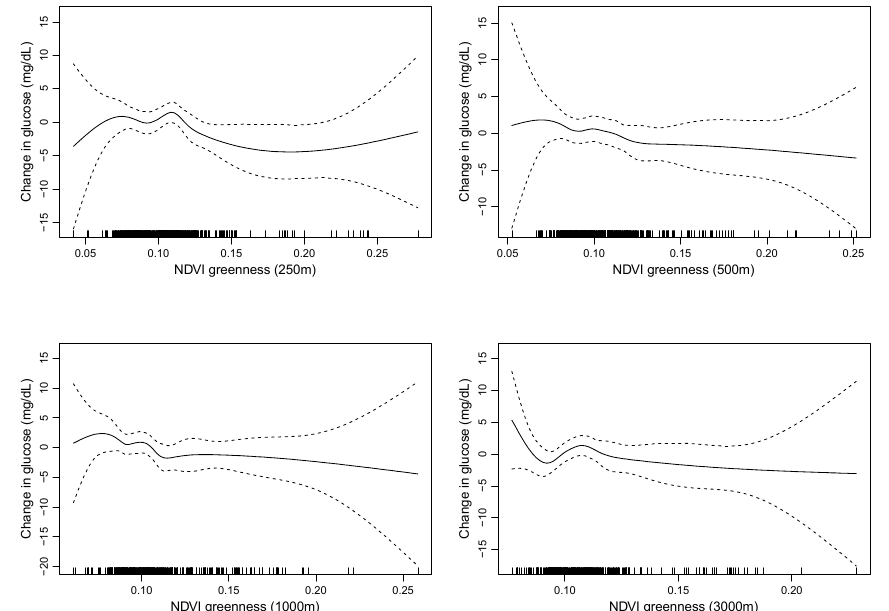
Figure 4. Penalized splines for the association between greenness measured at difference buffer sizes and changes in fasting glucose levels from generalized additive models adjusted for age, gender, Hispanic ethnicity, race, and socioeconomic status (maternal education level and income over poverty ratio). The solid line represents the change in glucose levels ( y axis) as a function of the exposure ( x axis) with tick marks on the x axis representing individual data points of the exposure distribution. Dotted lines represent 95% confidence intervals for the change in glucose levels.